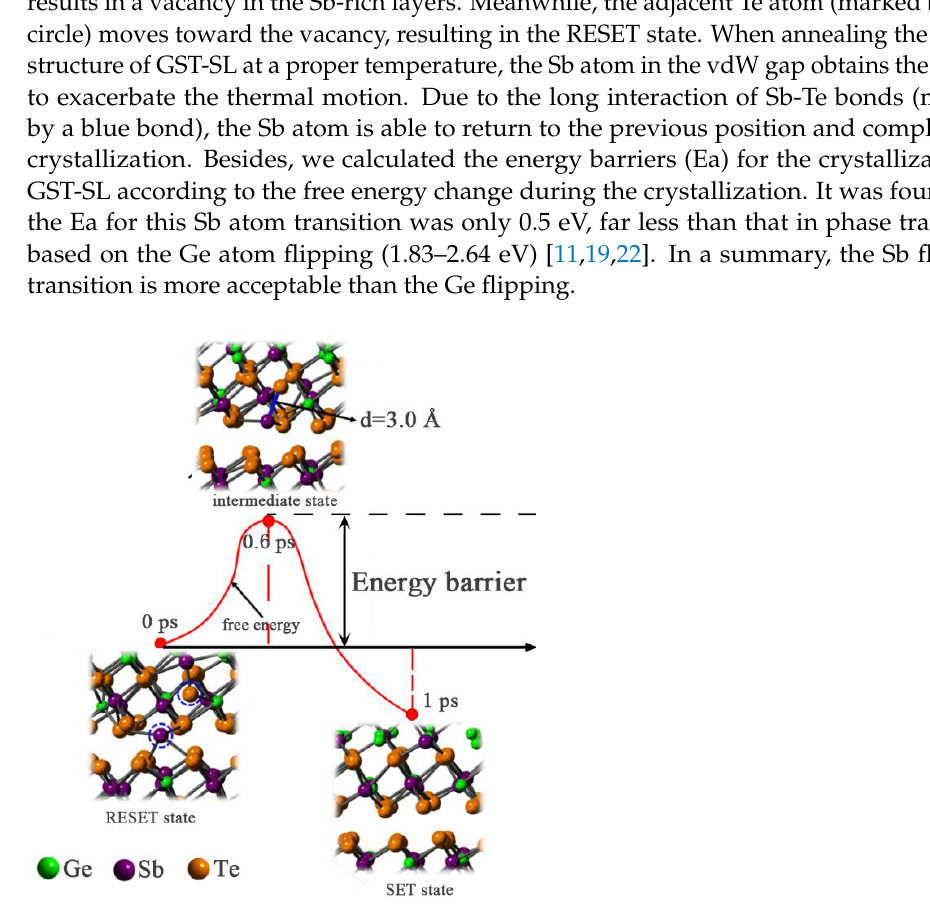
Figure 5. Schematic of the phase-change transition about GST-SL based on the Kooi-mix model. Finally, we performed energy band calculation and charge density analysis, GST-SL sampling was done using a 2 × 2 × 2 grid, all atoms were fully relaxed until the